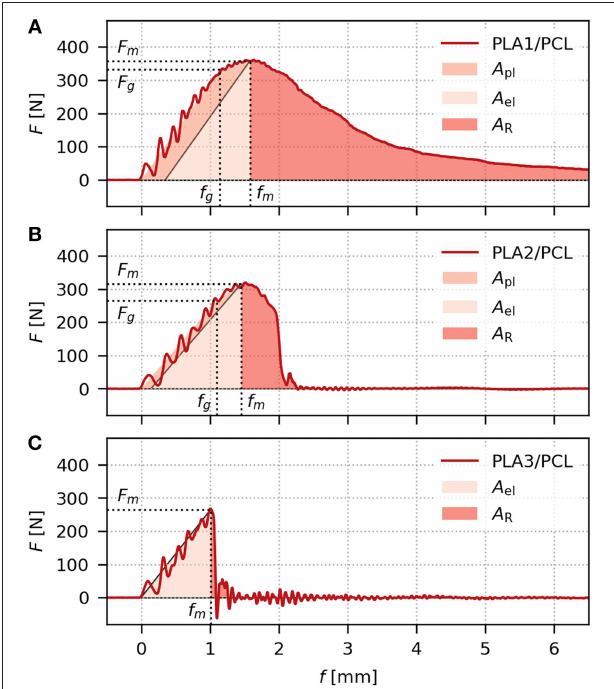
FIGURE 6 | Load-deflection curves ( F - f diagrams) of PLA/PCL(80/20) blends from the instrumented Charpy notched-impact test. The blends were prepared from the three different types of PLA with decreasing viscosity as described in Ostafinska et al. (2017): (A) the highest viscosity of PLA, (B) a medium viscosity of PLA, and (C) the lowest viscosity of PLA. Morphology of the blends and their integral impact strength are shown in Figures 4 , 5 , respectively. A el , A pl, and A R represent elastic, plastic and residual part of total fracture energy, respectively. F g and f g are the characteristic load and deflection values at yield, corresponding to the transition from elastic to elastic-plastic behavior, respectively; F m and f m are the characteristic load and deflection values corresponding to the onset of crack propagation, respectively. Adapted with permission from Ostafinska et al.